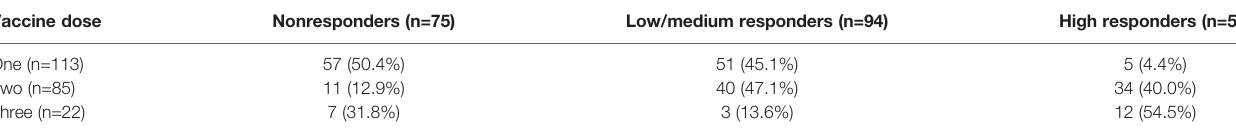
TABLE 3 | De fi nition of non, low/medium and high responders based on HBsAb titers and coverage. Vaccine